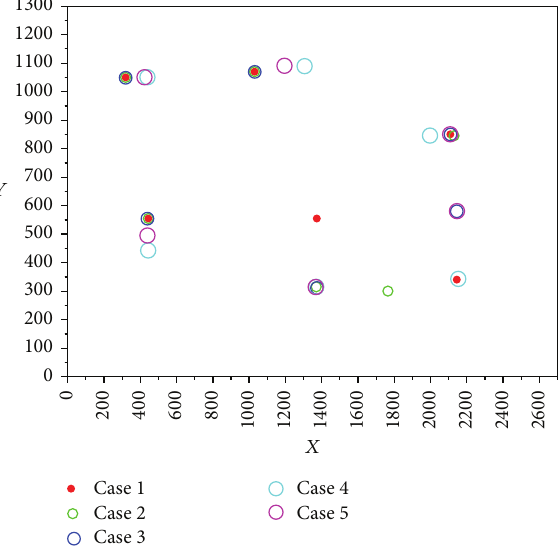
Figure 9: Coordinates of heating sources in comparison with different parameters (6 heat sources).